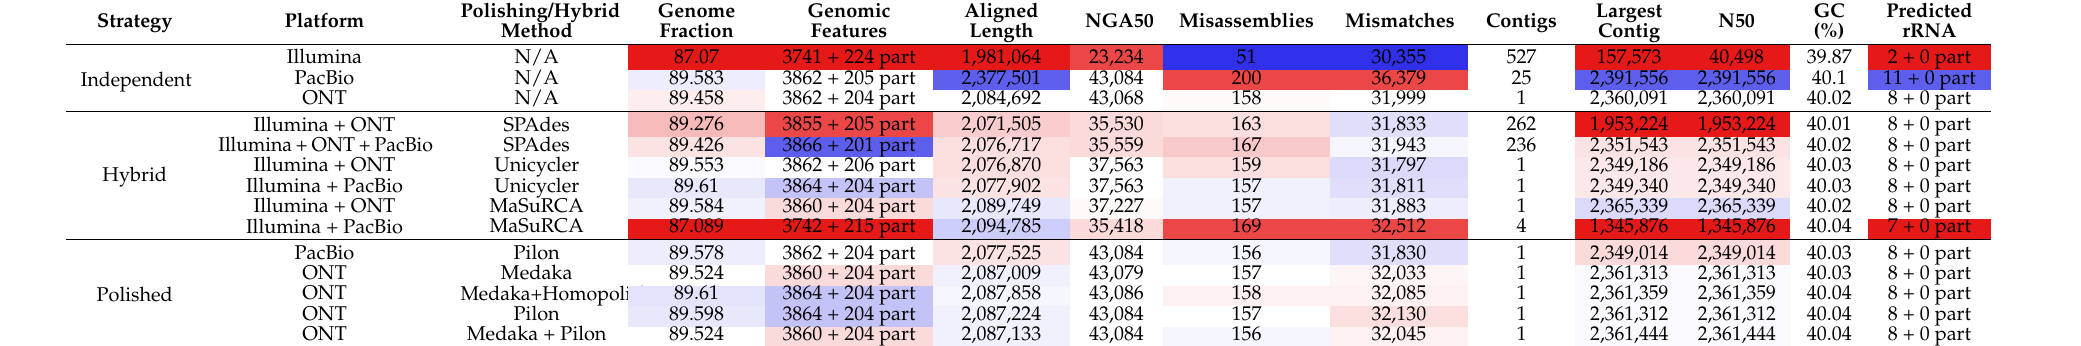
Table 4. Quality control results obtained with QUAST for the assemblies using different